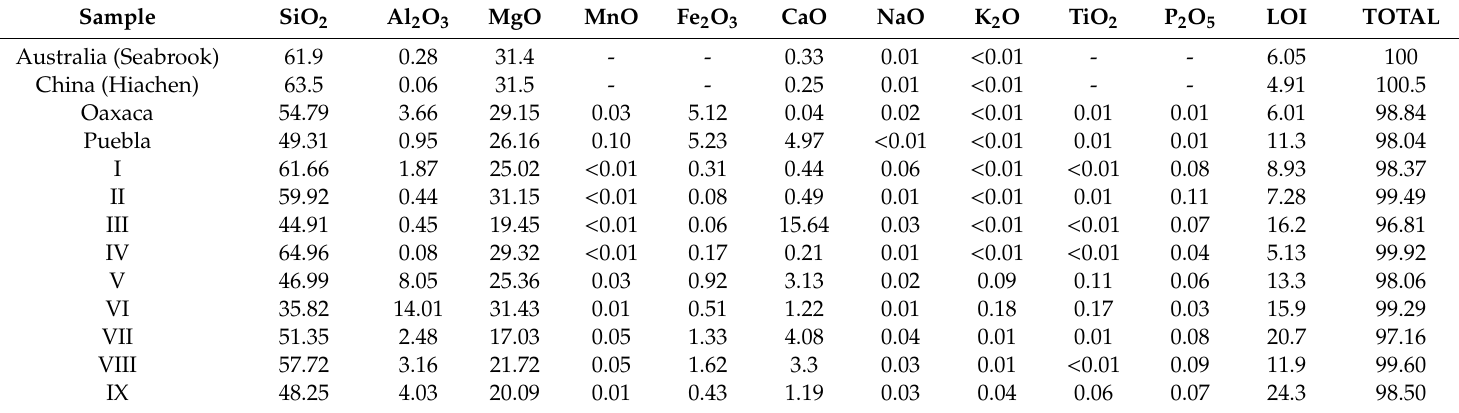
Table 5. Major element composition of natural Mexican talc from Oaxaca and Puebla ore deposits and high and low-priced packed products determined by XRF and its comparison with two high-grade talc ore deposits [1]. LOI = loss on ignition.